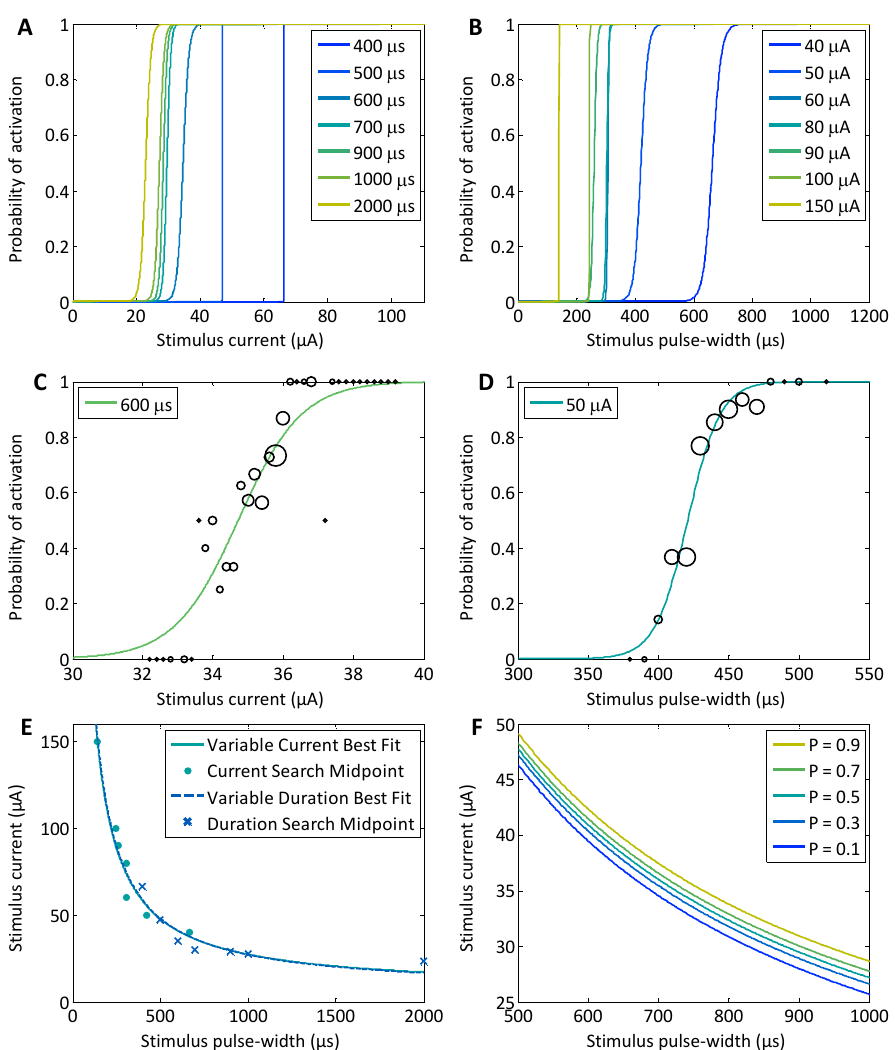
Figure 8. Shifting sigmoids are used to generate the strength–duration curve. Closed-loop experiments were performed to generate two sets of sigmoid activation curves corresponding to various constant pulse width and constant current searches. ( A , B ) The pulse-width parameter was fixed in ( A ); and the current pulse parameter was fixed in ( B ); CL searches yielded sigmoid activation curves, which shifted to lower currents with increasing stimulus pulse width and shorter pulse widths with increasing stimulus pulse currents. The sigmoids appear to be extremely steep because the stimulus space is large; ( C , D ) Two sigmoid activation curves are highlighted by zooming in on the independent axis to demonstrate that the slopes span a significant stimulus range of 2.0 µ A and 25 µ s. The open circles overlaying the activation curves are a measure of the activation probability at a given stimulus level and are proportional in size to the number of stimuli that were applied at that stimulus; ( E ) The strength-duration curve, for a probability of 0.5, was built in two ways. Each of the sigmoid models were used to predict the stimulus that would produce an activation probability of 0.5 for the constant pulse-width (dots) and constant current (“X’s”) searches. The best fit of the strength-duration curve for both sets of searches (solid lines) was calculated using a nonlinear least squares curve fit of Equation (2); ( F ) Strength–duration curves were constructed using Equation (2) for probability levels spanning from 0.1 to 0.9 in 0.2 increments (increasing probability, from dark to light).